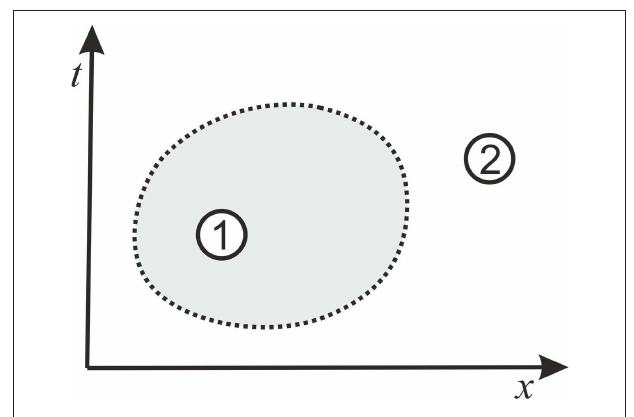
FIGURE 1 | Continuity of Action. If information from event 1 can influence event 2, then this information must affect any closed three surface around 1.